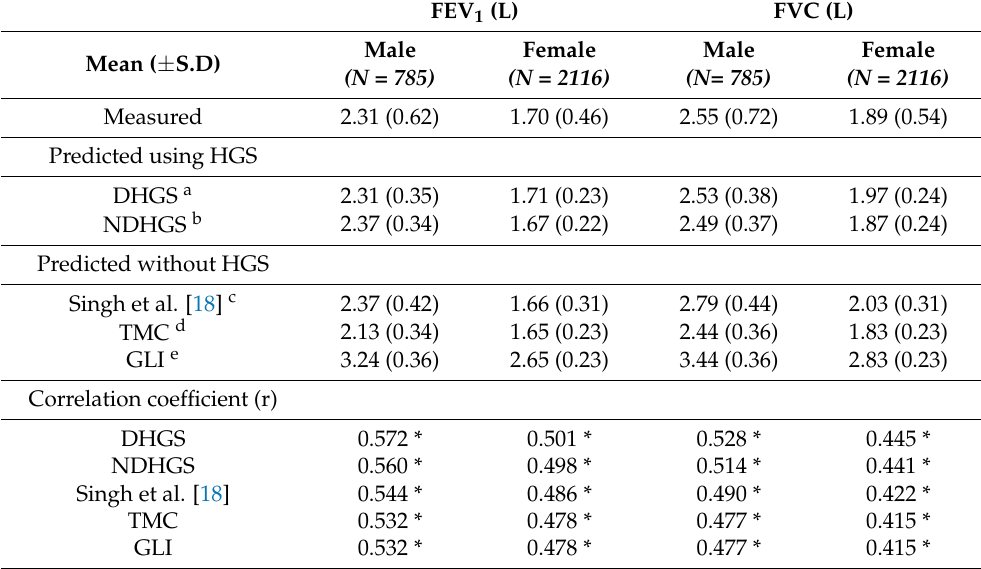
Table 4. Comparison between the measured and predicted values of the lung function